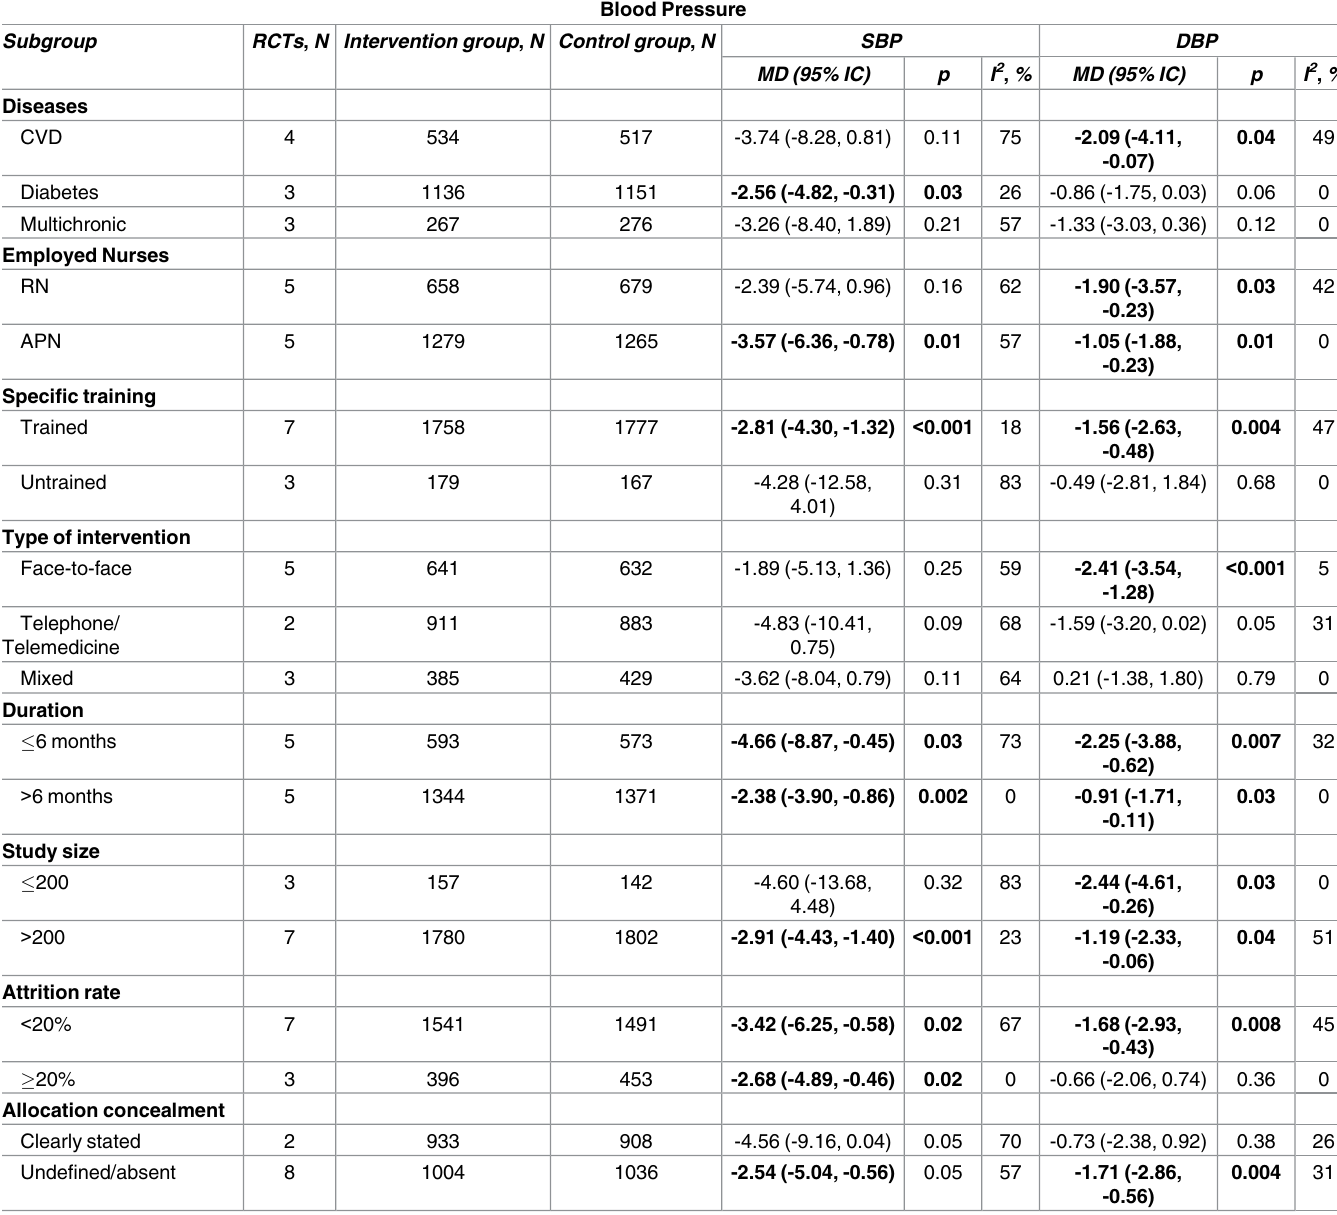
Table 4. Meta-analysis of the reduction of blood pressure levels stratified by level and training of employed nurses; type and duration of the inter- vention; study size; attrition rate; allocation